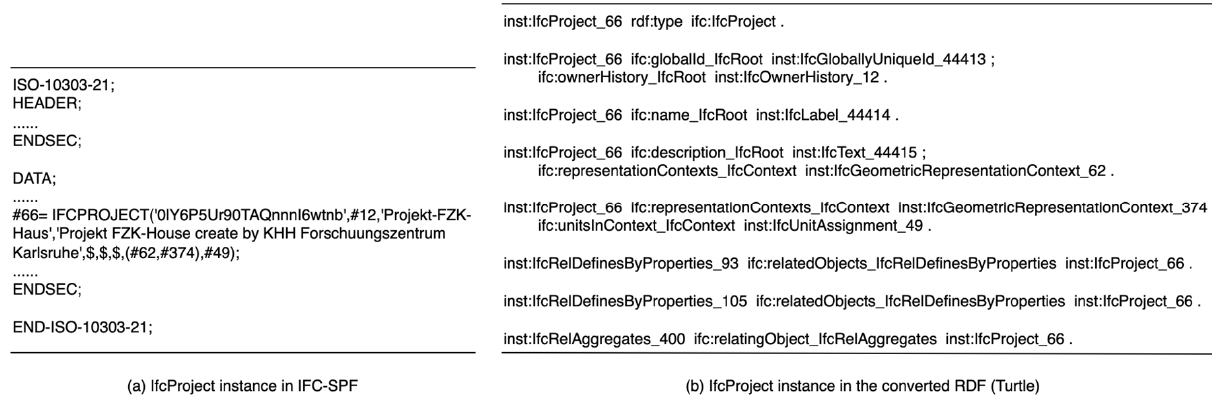
Figure 12. An example for the IFC-to-RDF